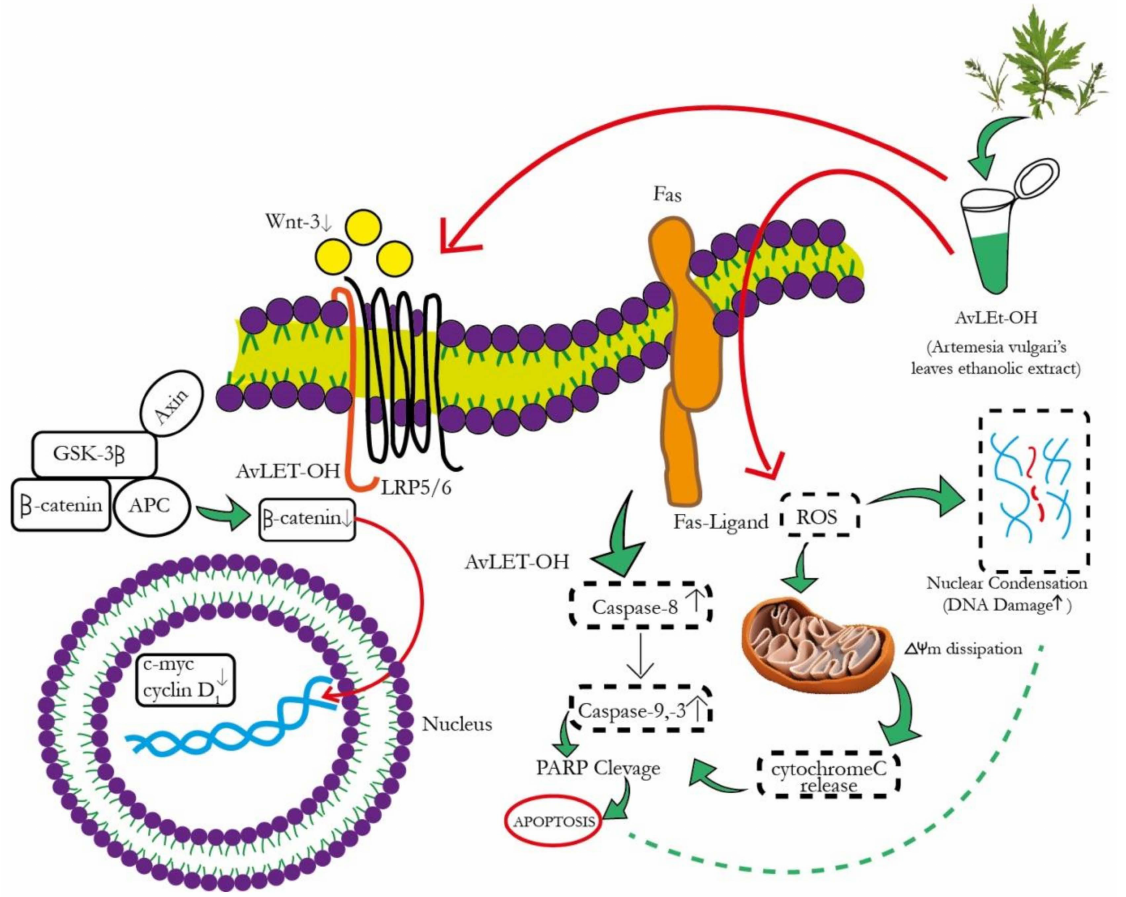
Figure 13. Schematic representation of the mechanism of action of AvL -EtOH against NSCLC. AvL -EtOH inhibits the proliferation of A549 lung cancer cells, leading to apoptosis and downregula- tion of the Wnt/ β -catenin signaling